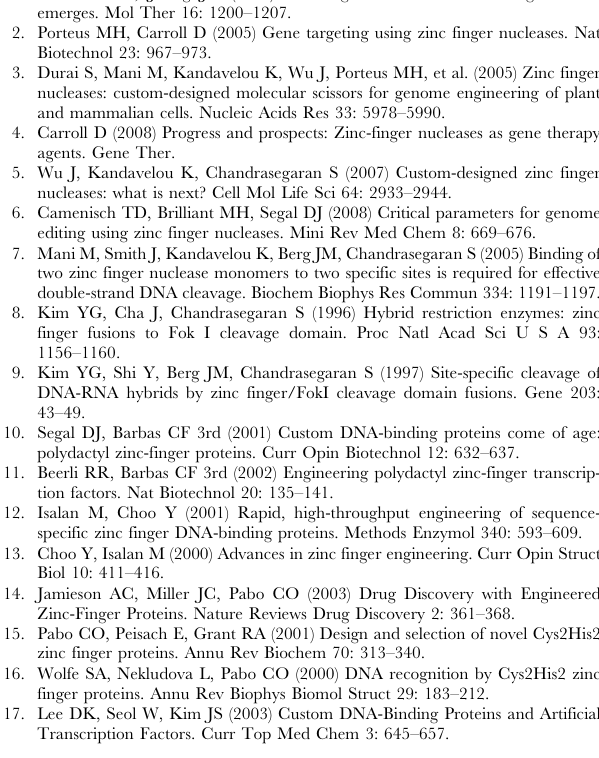
Table S22 Potential OPEN ZFN target sites in gene transcripts encoded on zebrafish chromosome 22. Data presented as described in the legend to Table S1.